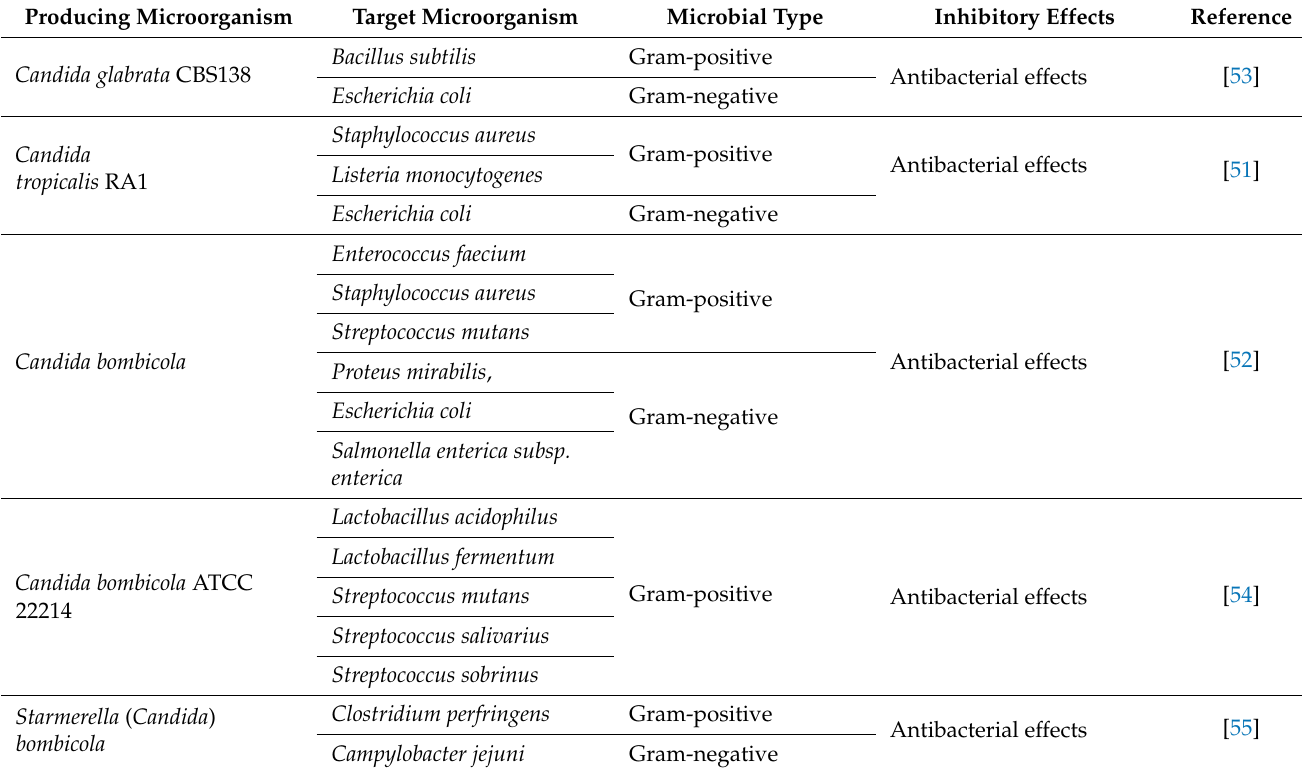
Table 2. Antimicrobial effects of